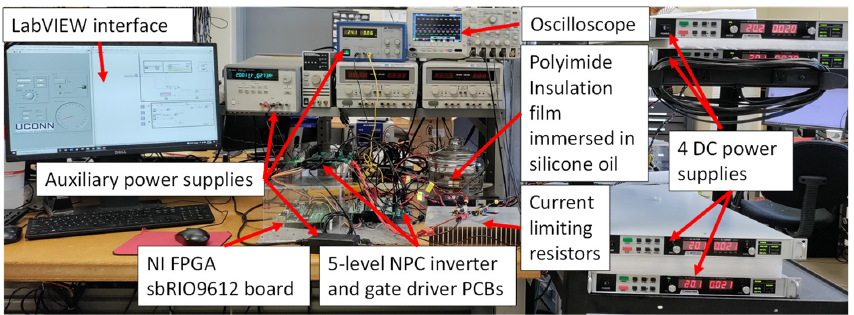
Figure 15. Experimental setup—NPC multilevel inverter.